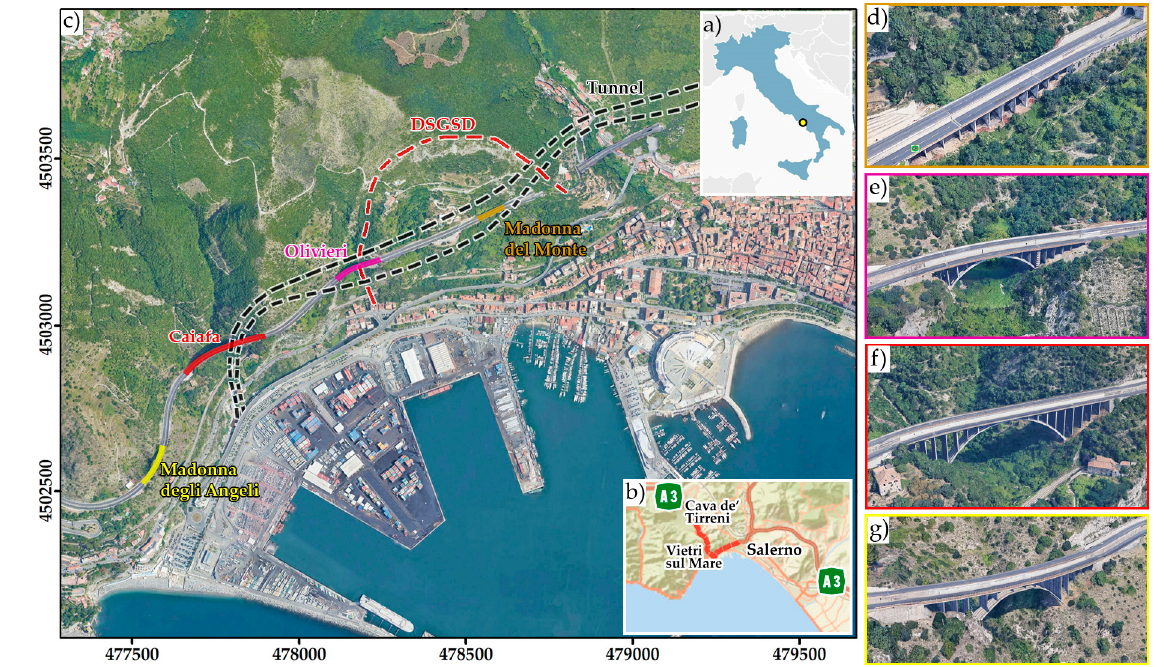
Figure 1. Focus area. ( a ) Map of Italy showing the location of focus area; ( b ) section of A3 highway analyzed; ( c ) excerpt of map showing the location of the four viaducts being analyzed, north of the Salerno port and ( d – g ) perspective views of the four viaducts in order: Madonna del Monte, Olivieri, Caiafa and Madonna degli Angeli.